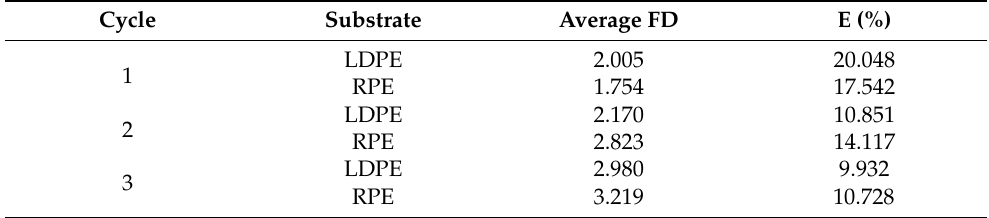
Table A3. Cyclic GMA grafting onto PE. Extruder temperature: 175–180–185–180–175 ◦ C. Screw